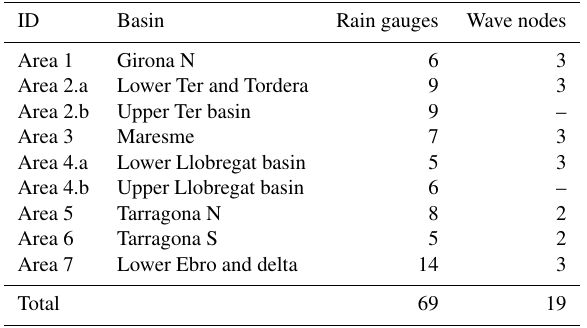
Table 1. Number of selected rain gauges and waves nodes in the different areas along the coast (Fig.